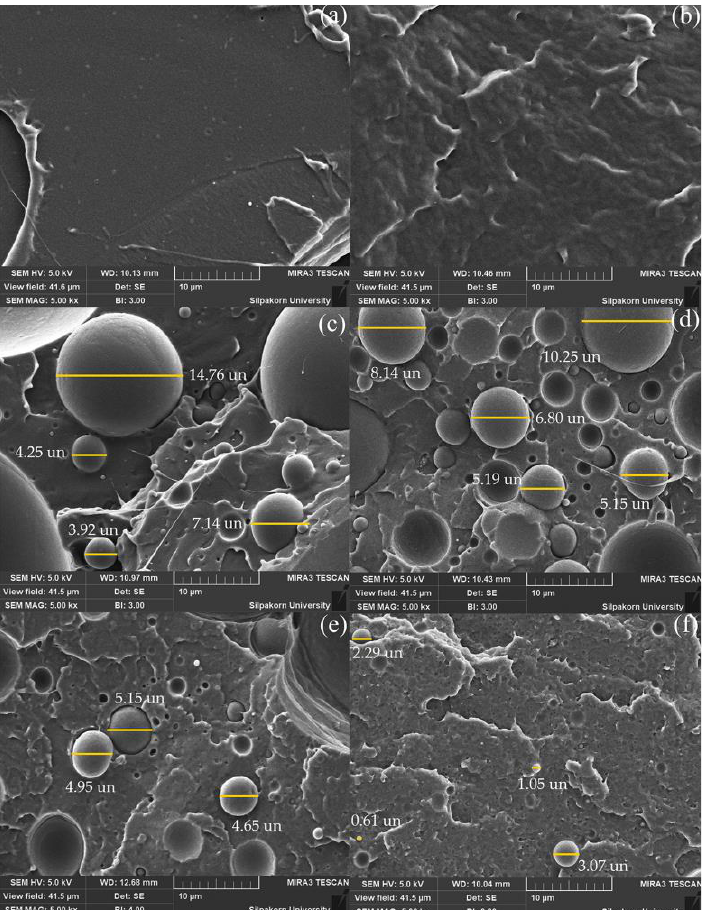
Figure 3. SEM micrograph of the tensile fractured specimen for PLA, PP, and PLA/PP blends with LNR−g−MMA as a compatibilizer. ( a ) PLA, ( b ) PP, ( c ) PLA/PP/0.0, ( d ) PLA/PP/2.5, ( e ) PLA/PP/5.0, and ( f ) PLA/PP/10.0. The yellow lines indicate the diameter.